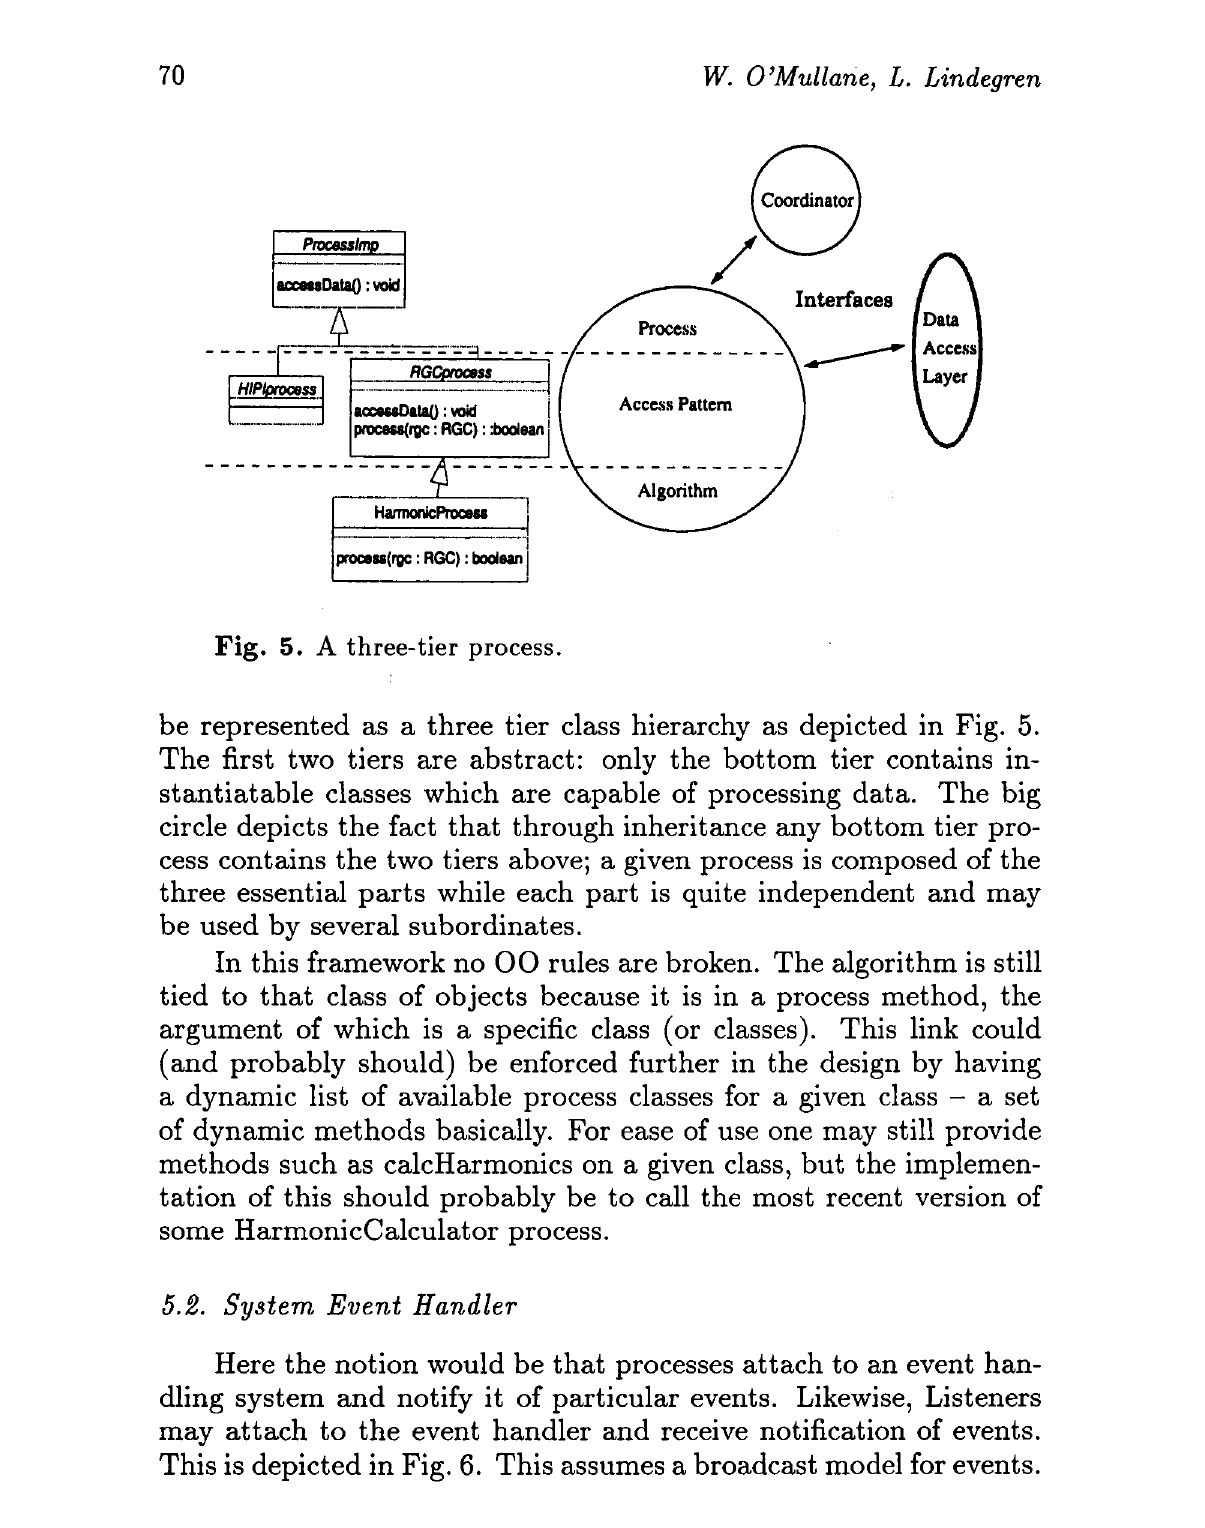
Fig. 5. A three-tier